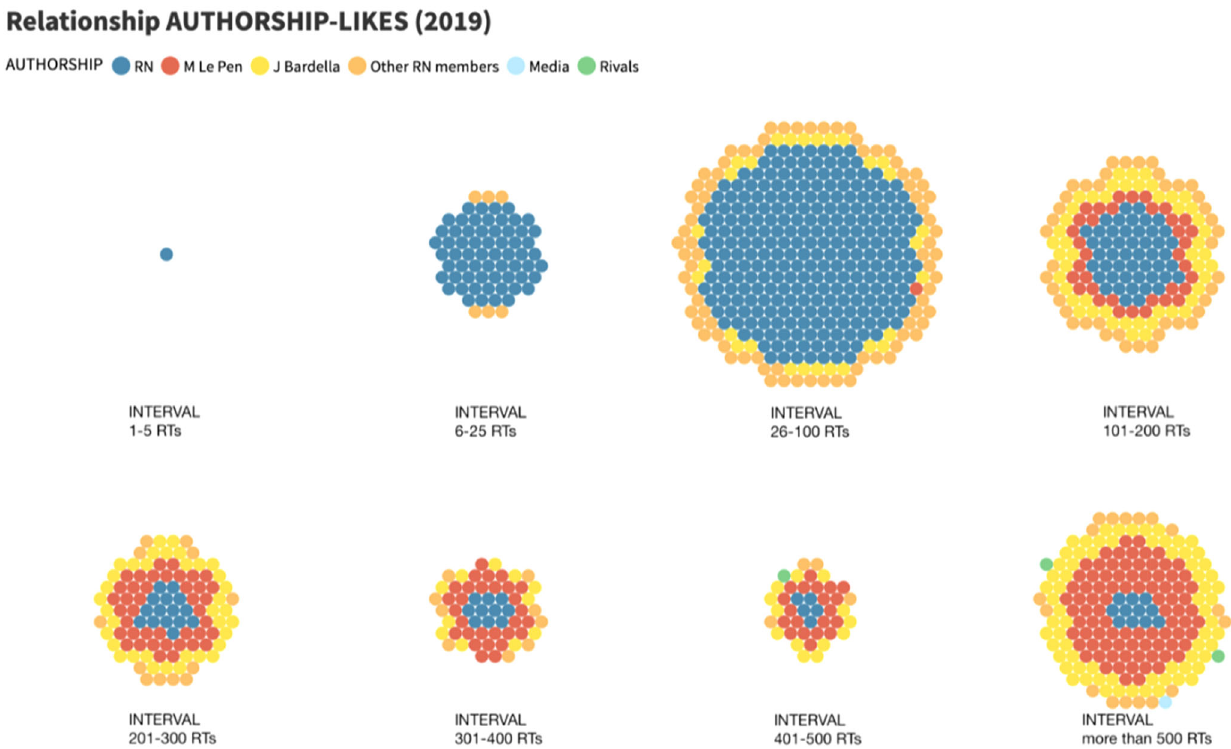
Fig. 4 Relationship between RN authorship and range in favourites/Own elaboration.